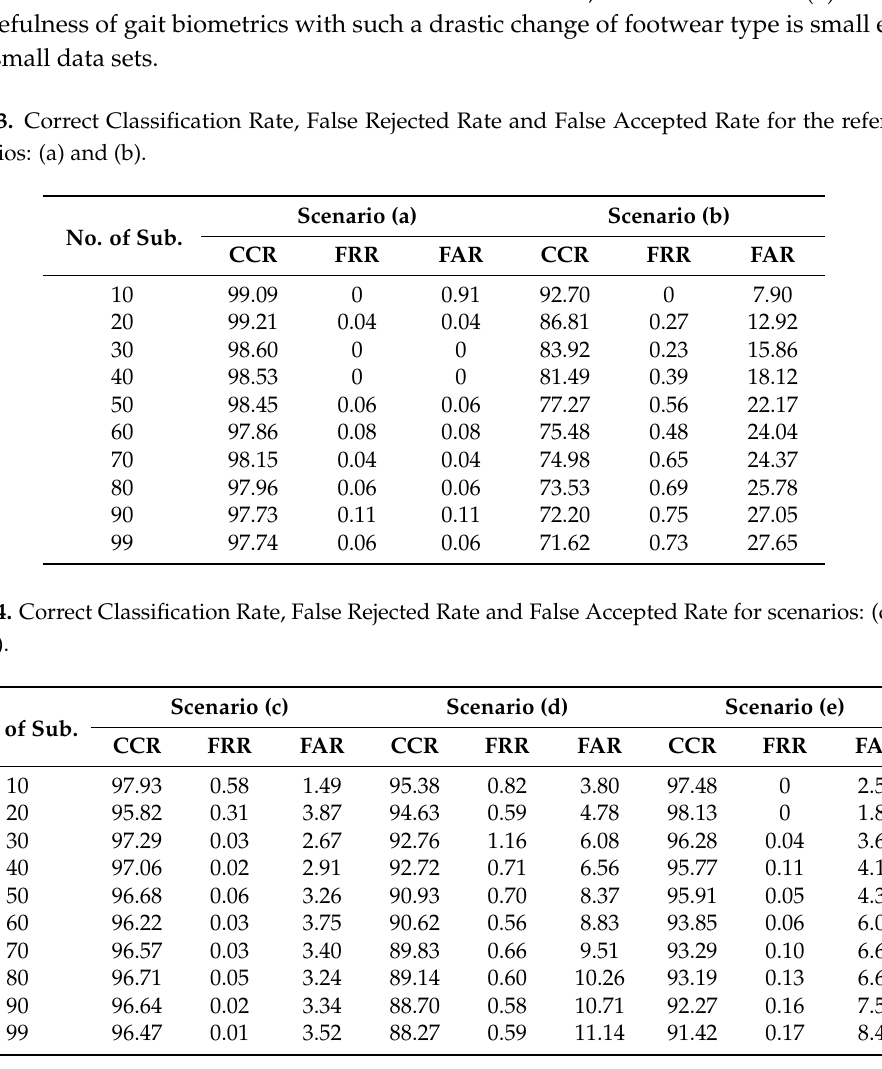
Table 3. Correct Classification Rate, False Rejected Rate and False Accepted Rate for the reference scenarios: (a) and (b).